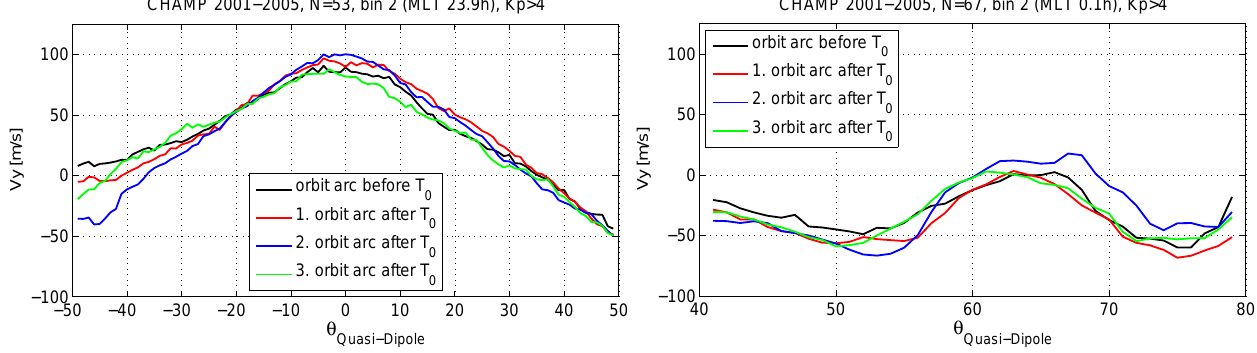
the equator (travelling path: 2 πr sat · 74 ◦ / 360 = 8745 km, with r sat = 6766 . 5 km being the mean satellite altitude on the path from 74 ◦ Mlat to the magnetic equator; travelling time: 3.75 h on average). The timing uncertainty of ± 0 . 5 h